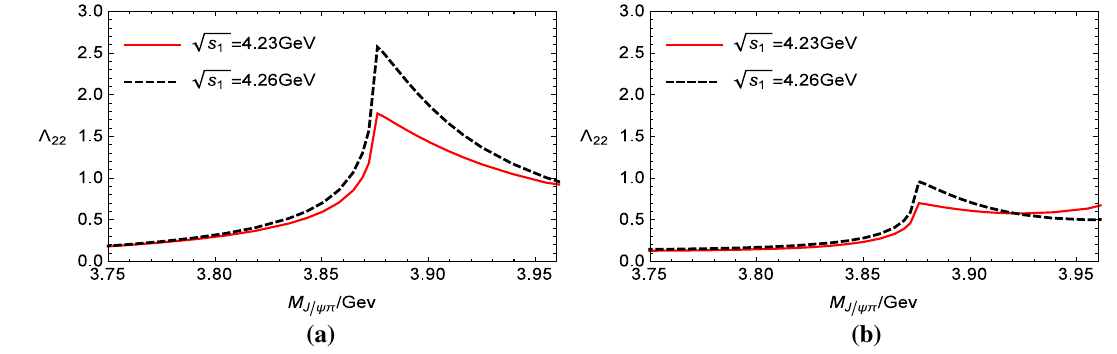
Fig. 7 The dominant contribution to the J /ψππ process. a S -wave D ∗ π interaction in D 1 D ∗ π vertex; b D -wave D ∗ π interaction in D 1 D ∗ π